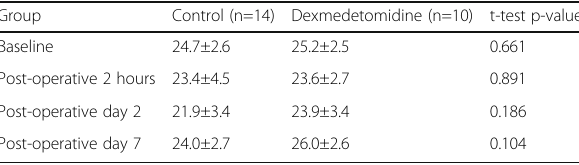
Table 1 (abstract 0064). Total small vessel density (mm/mm2). Repeated-measure ANOVA revealed time p=0.004, group p=0.805 and time x group p=0.382